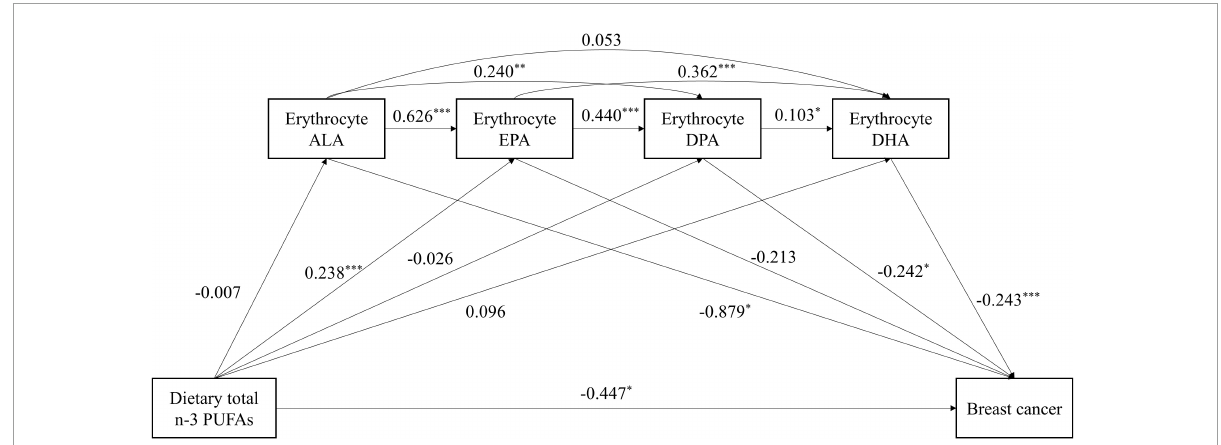
FIGURE3 The chain mediating effect of erythrocyte n – 3 PUFAs on the relationship between dietary total n – 3 PUFA intake and breast cancer risk. ALA, α -linolenic acid; DHA, docosahexaenoic acid; DPA, docosapentaenoic acid; EPA, eicosapentaenoic acid; PUFA, polyunsaturated fatty